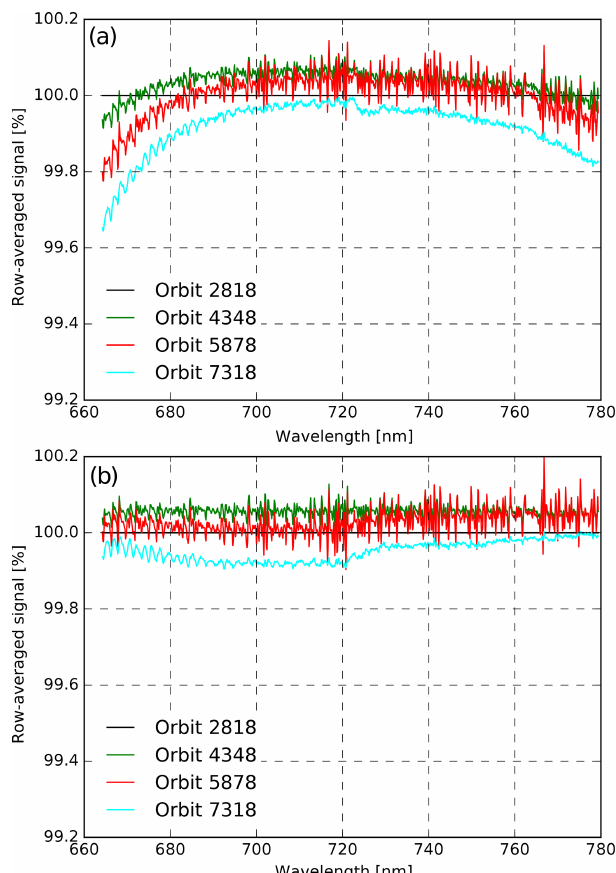
Figure 16. Normalized irradiance measurements for the SWIR de- tector for QVD1 (a) and QVD2 (b) over time. Signals are shown as row averages versus wavelength. Shown are orbits 2818 and 2819 (black flat line), 4348 and 4349 (green), 5878 and 5879 (red), and 7318 and 7319 (cyan). The spread of signal values for the different orbits shows neither a trend nor a wavelength